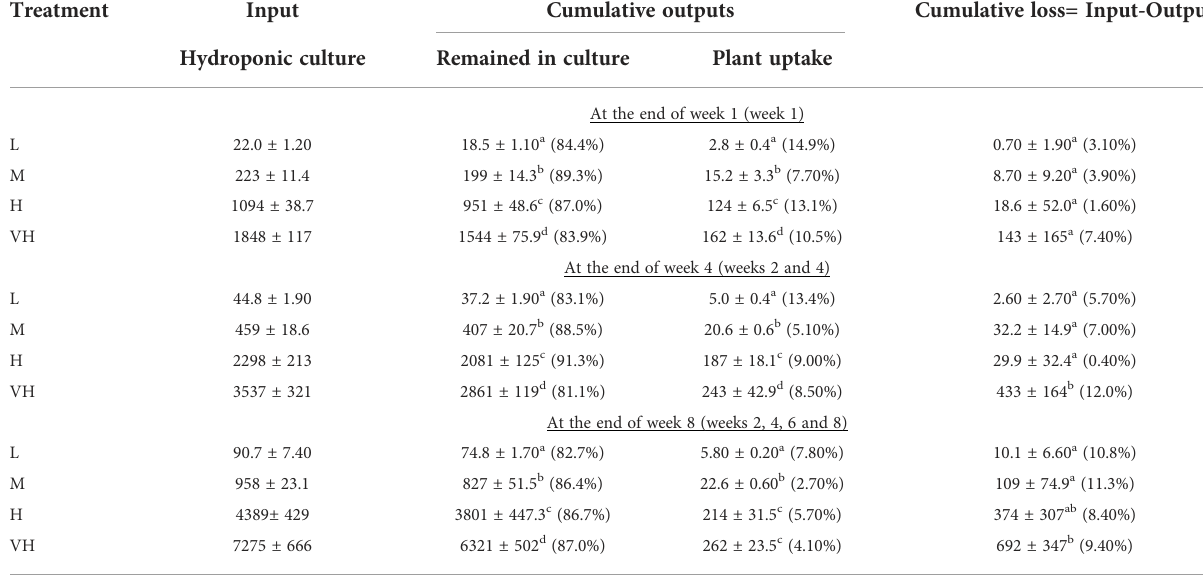
TABLE 2 Amounts of BDE-209 (µg) and percentages to total inputs (in brackets) remained in hydroponic culture solution, uptake in K. obovata seedlings and loss during an 8-week hydroponic experiment.